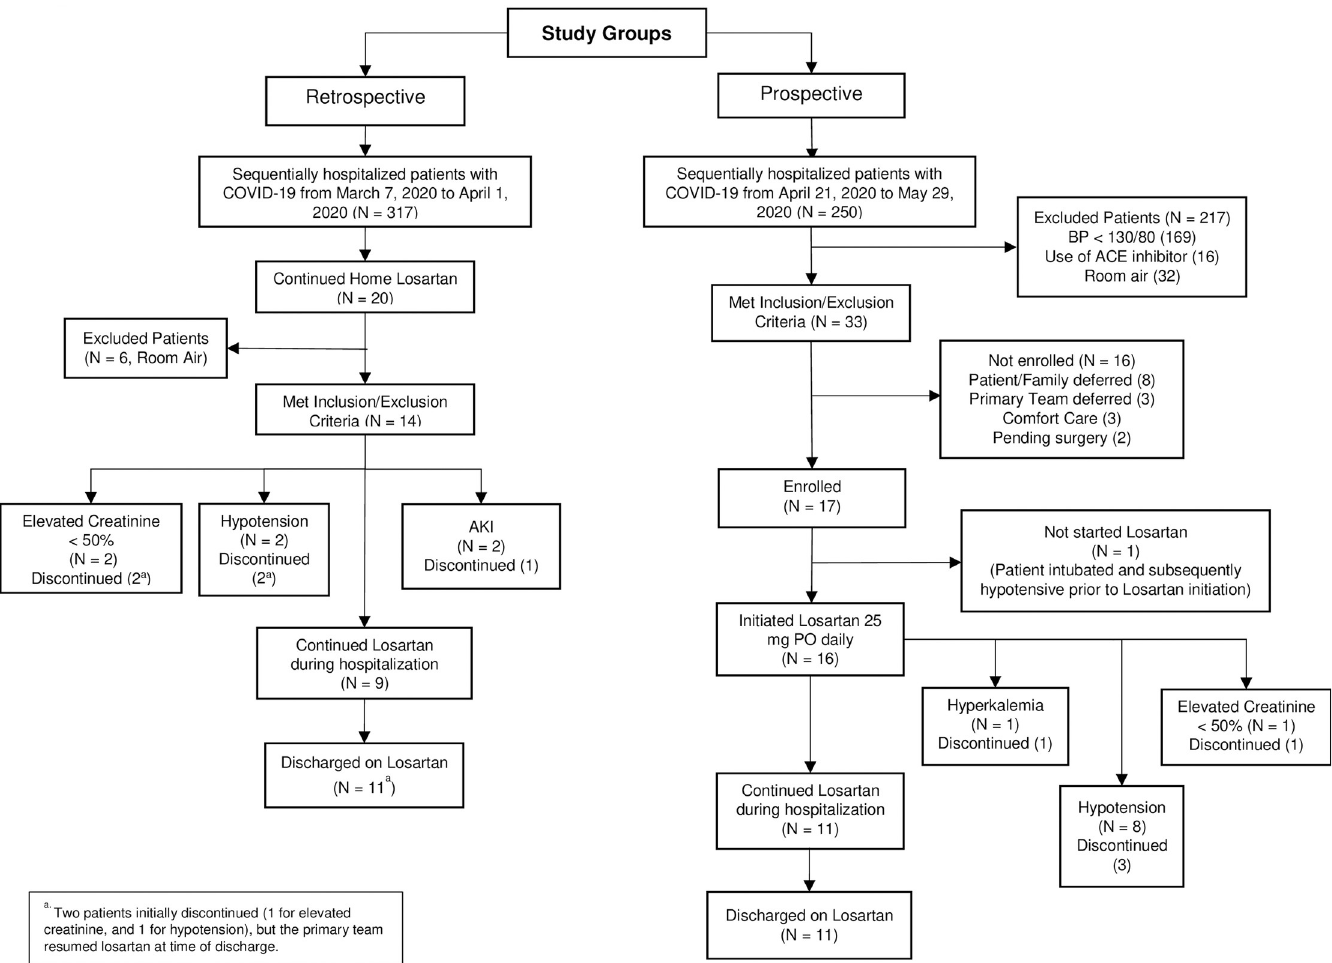
Fig 1. Flow chart of selection of the two study cohorts in the study, prospective and retrospective cohort. Total number of individuals that met the specific inclusion/exclusion criteria for enrollment as well as adverse events are shown.